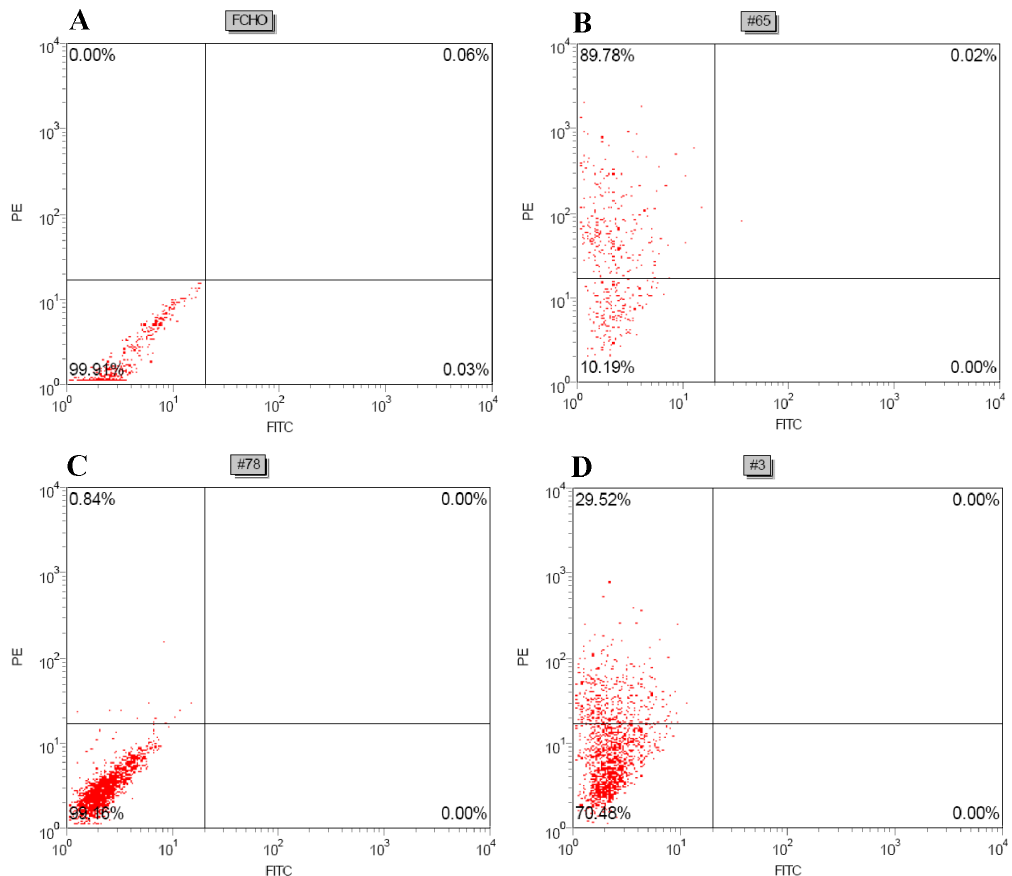
Figure 4. Antibody expression through FCS-containing vector. Flip-In CHO cells (FCHO) stably transfected by plasmid DNA were stained by PE-conjugated mouse-anti-human kappa chain antibodies (PE-Kappa) and then analyzed by FACS. ( A ) FCHO, no staining; ( B ) pDGB4, PE-Kappa staining; ( C ) pDGB4-noTM, PE-Kappa staining; and ( D ) pDGB4-FCS, PE-Kappa staining.